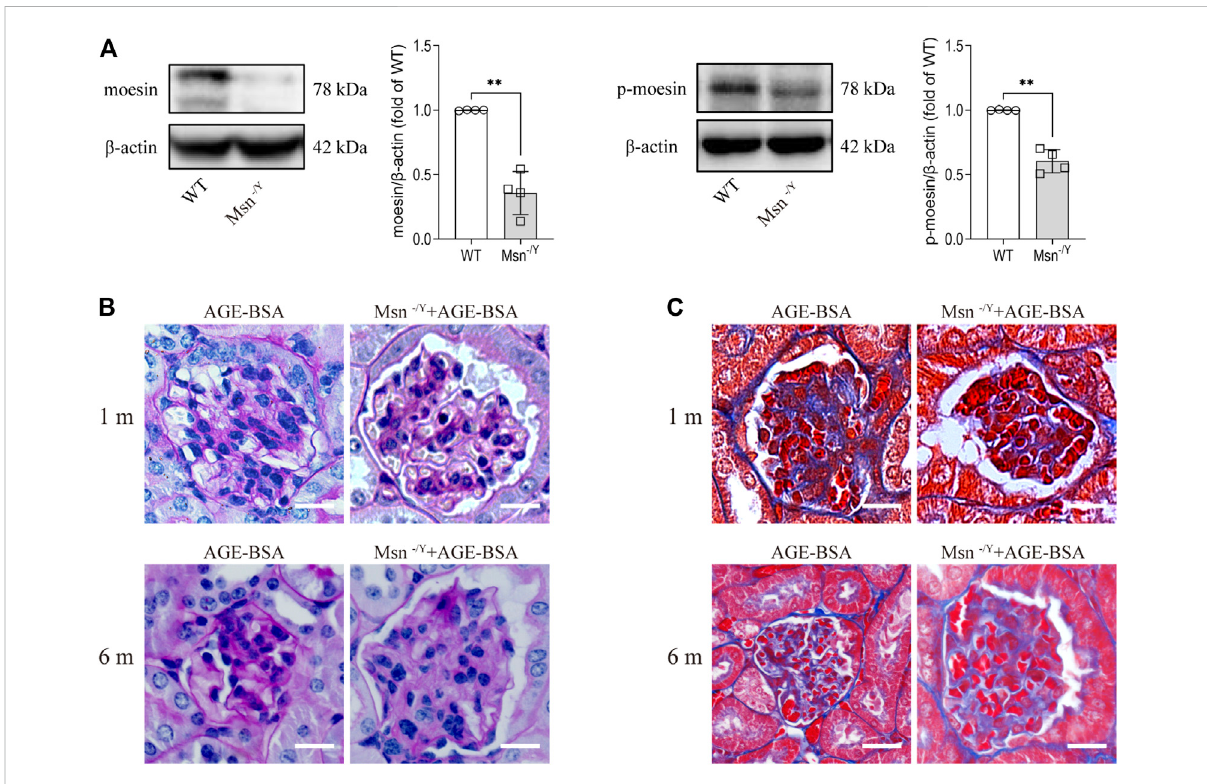
FIGURE 8 Moesinde fi ciencyattenuatedAGE-BSA-inducedrenal fi brosis. (A) Ef fi ciencyofmoesinknockoutinmicewascon fi rmedbyWesternblot. n =4. ** p < 0.01. (B) PAS and (C) Masson ’ s staining were conducted in renal tissue from both 1 and 6 m AGE-BSA-treated Msn − /Y mice and compared with AGE-treated WT